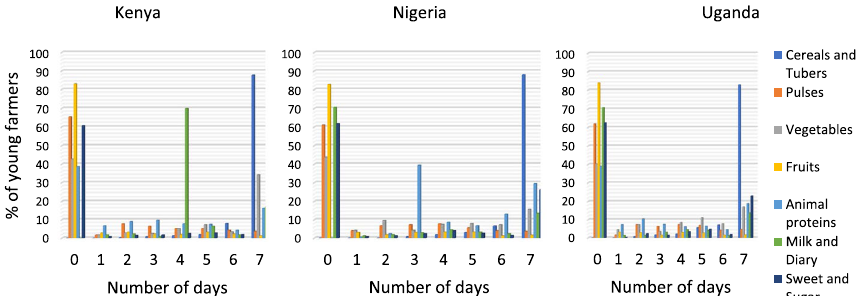
Fig. 2 Food consumption in Kenya, Nigeria, Uganda